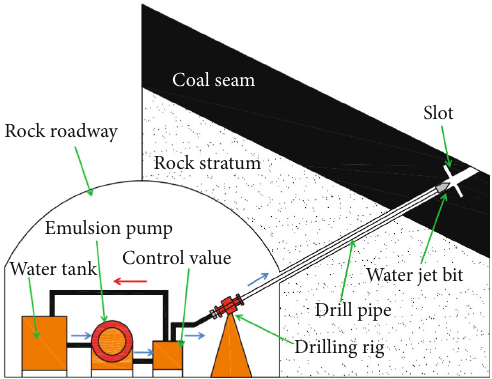
Figure 6: Schematic diagram of underground hydraulic slotting (Modi fi ed from [34]).